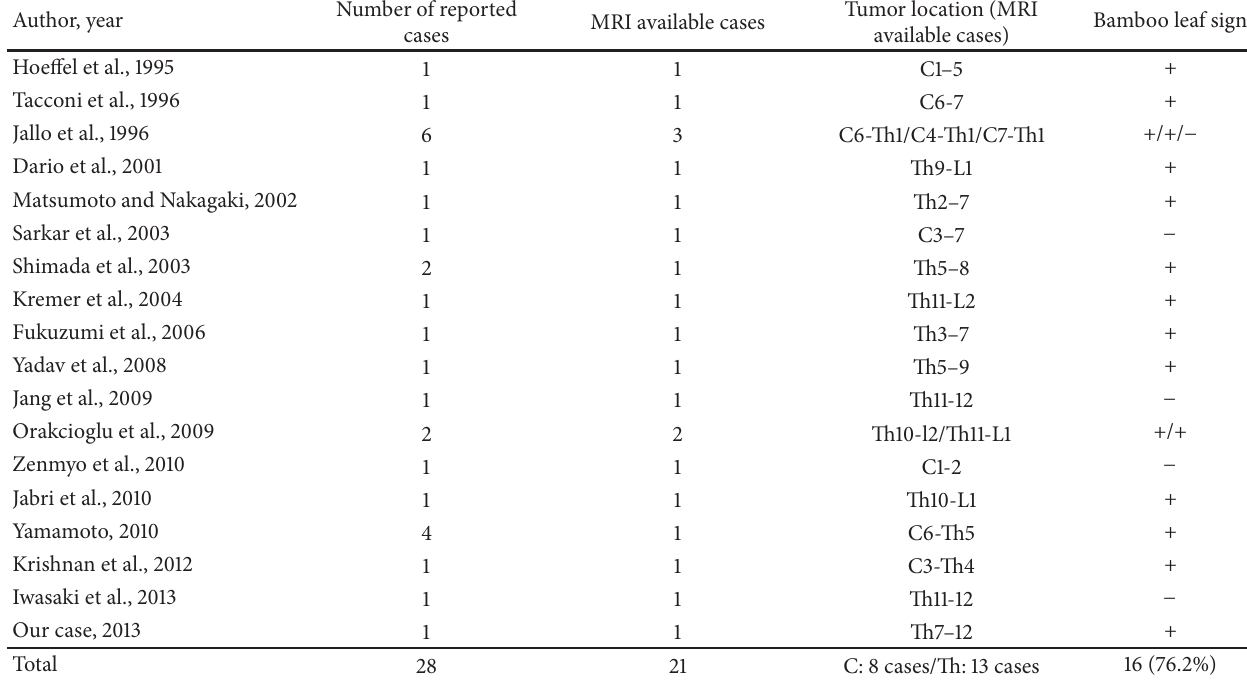
Table 1: Summary of cases of spinal subependymomas reported since 1995.